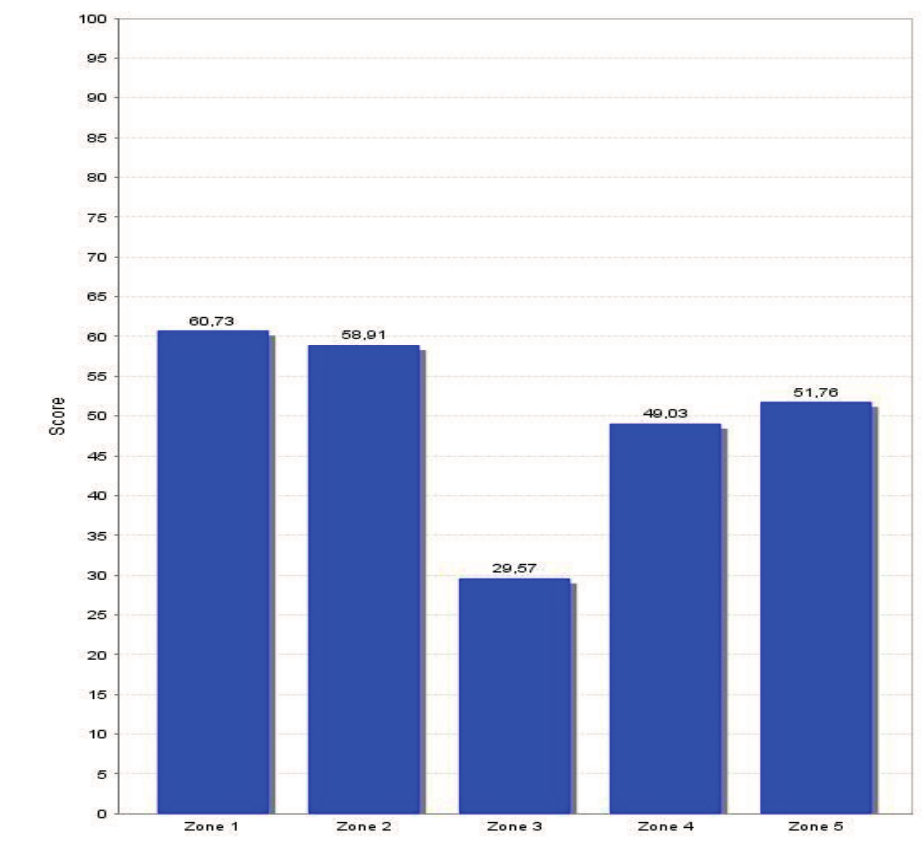
Figure 6. Global index by zones in the Serra d’Espadà Natural Park. D-Sight